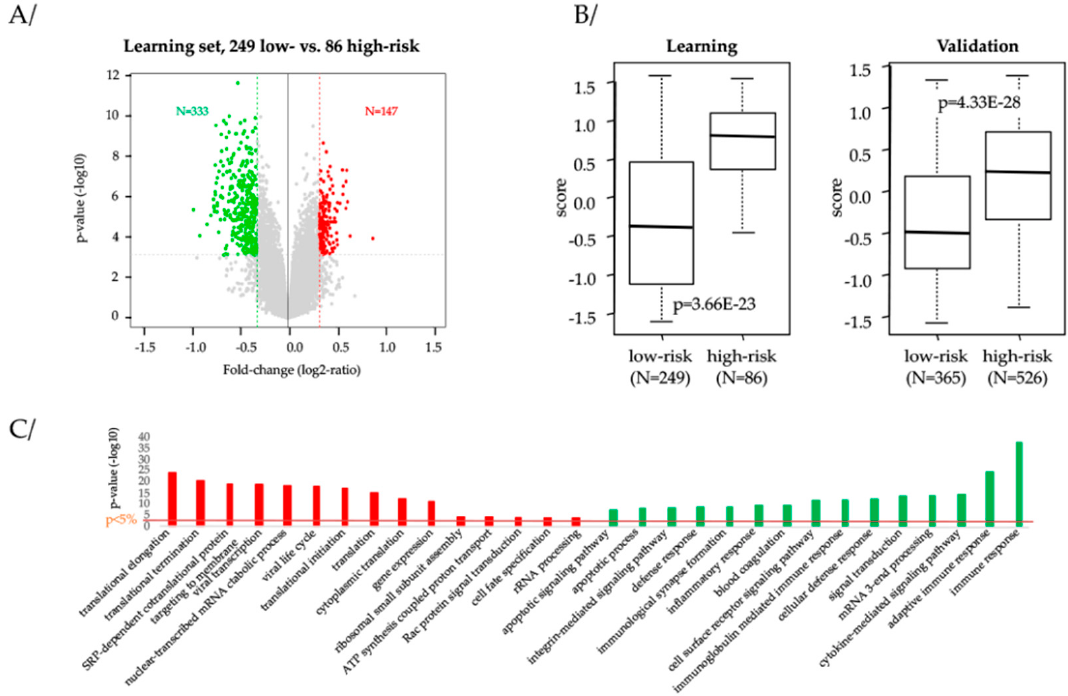
Figure 4. Supervised analysis of expression profiles between the “high-risk” and “low-risk” TNBC according to our 13-gene classifier. ( A ) Volcano plot showing the 480 genes di ff erentially expressed in the learning set (Metabric), including 333 overexpressed in “low-risk” samples and 147 overexpressed in “high-risk” samples. ( B ) The metagene-based prediction score is significantly higher (Student t -test) in the “high-risk” samples than in the “low-risk” samples in the learning set as expected (left), but also in the independent validation set (right). ( C ) Gene ontology (GO) biological processes of the DAVID database associated with the 480-gene list. The barplot indicates the − log( p -value) (y-axis) of the top 15 biological pathways (x-axis) that are enriched for genes overexpressed in the “high-risk” samples versus the “low-risk” samples (in red) and that are enriched for genes overexpressed in the “low-risk” samples versus the “high-risk” samples (in green). The p-value threshold is indicated by the orange horizontal line.